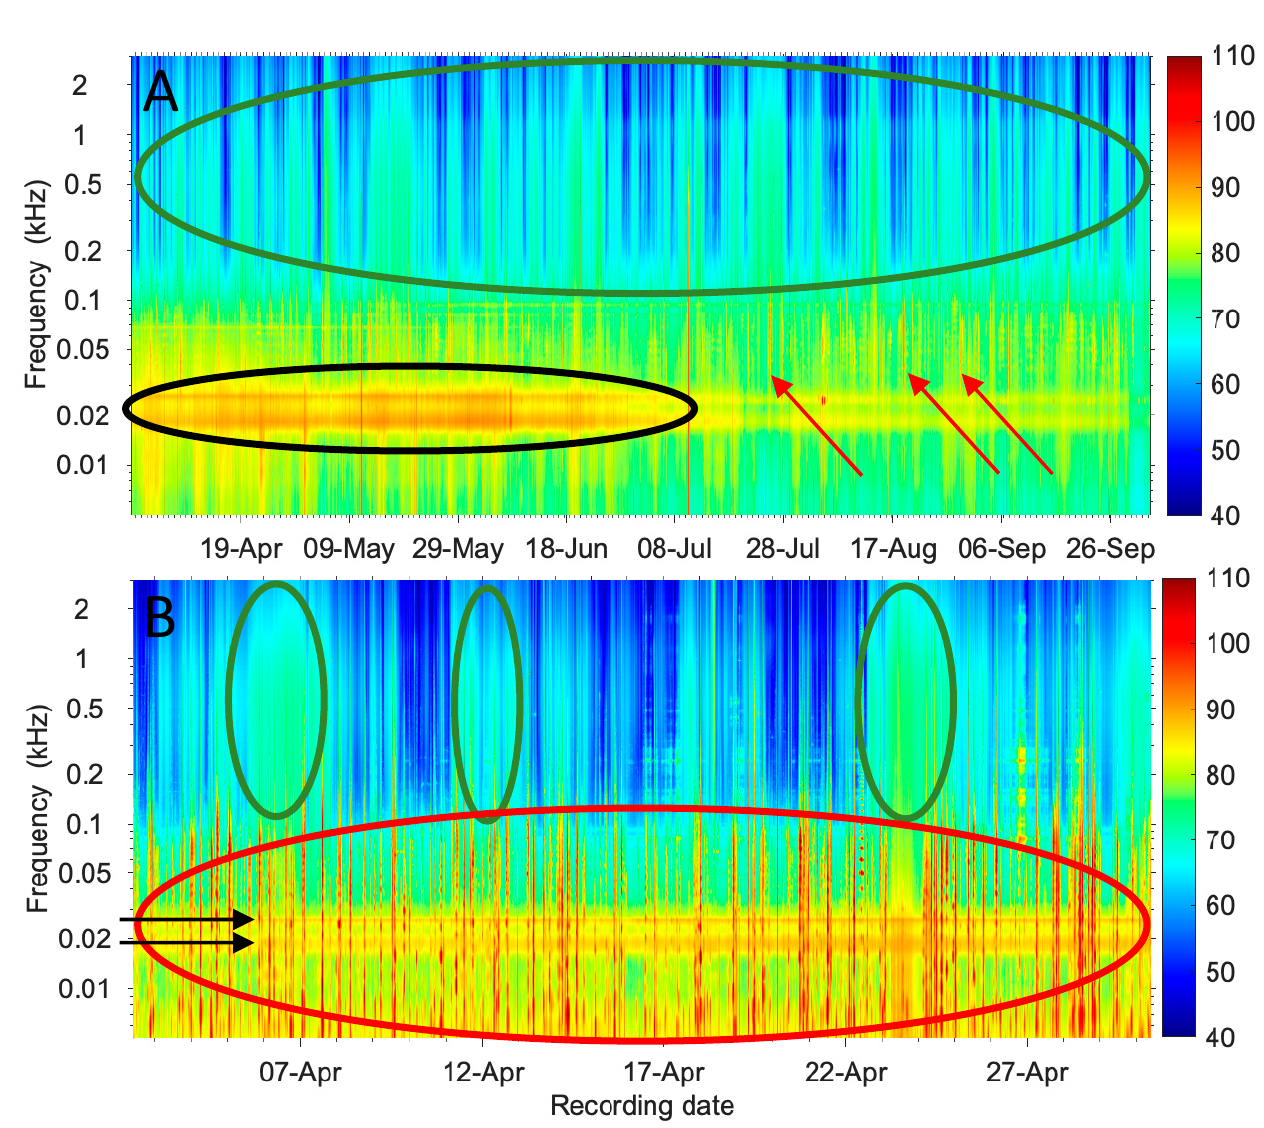
Figure 8. LTSAs [dB re 1 µ Pa 2 /Hz] near ( A ) the Bremer Canyon, WA, site 16, and ( B ) Tuncurry, NSW, site 25. The contributions from ships, wind, and Antarctic blue whales ( Balaenoptera musculus intermedia ) are marked in red, green, and black, respectively. Only a few ships are marked in ( A ).